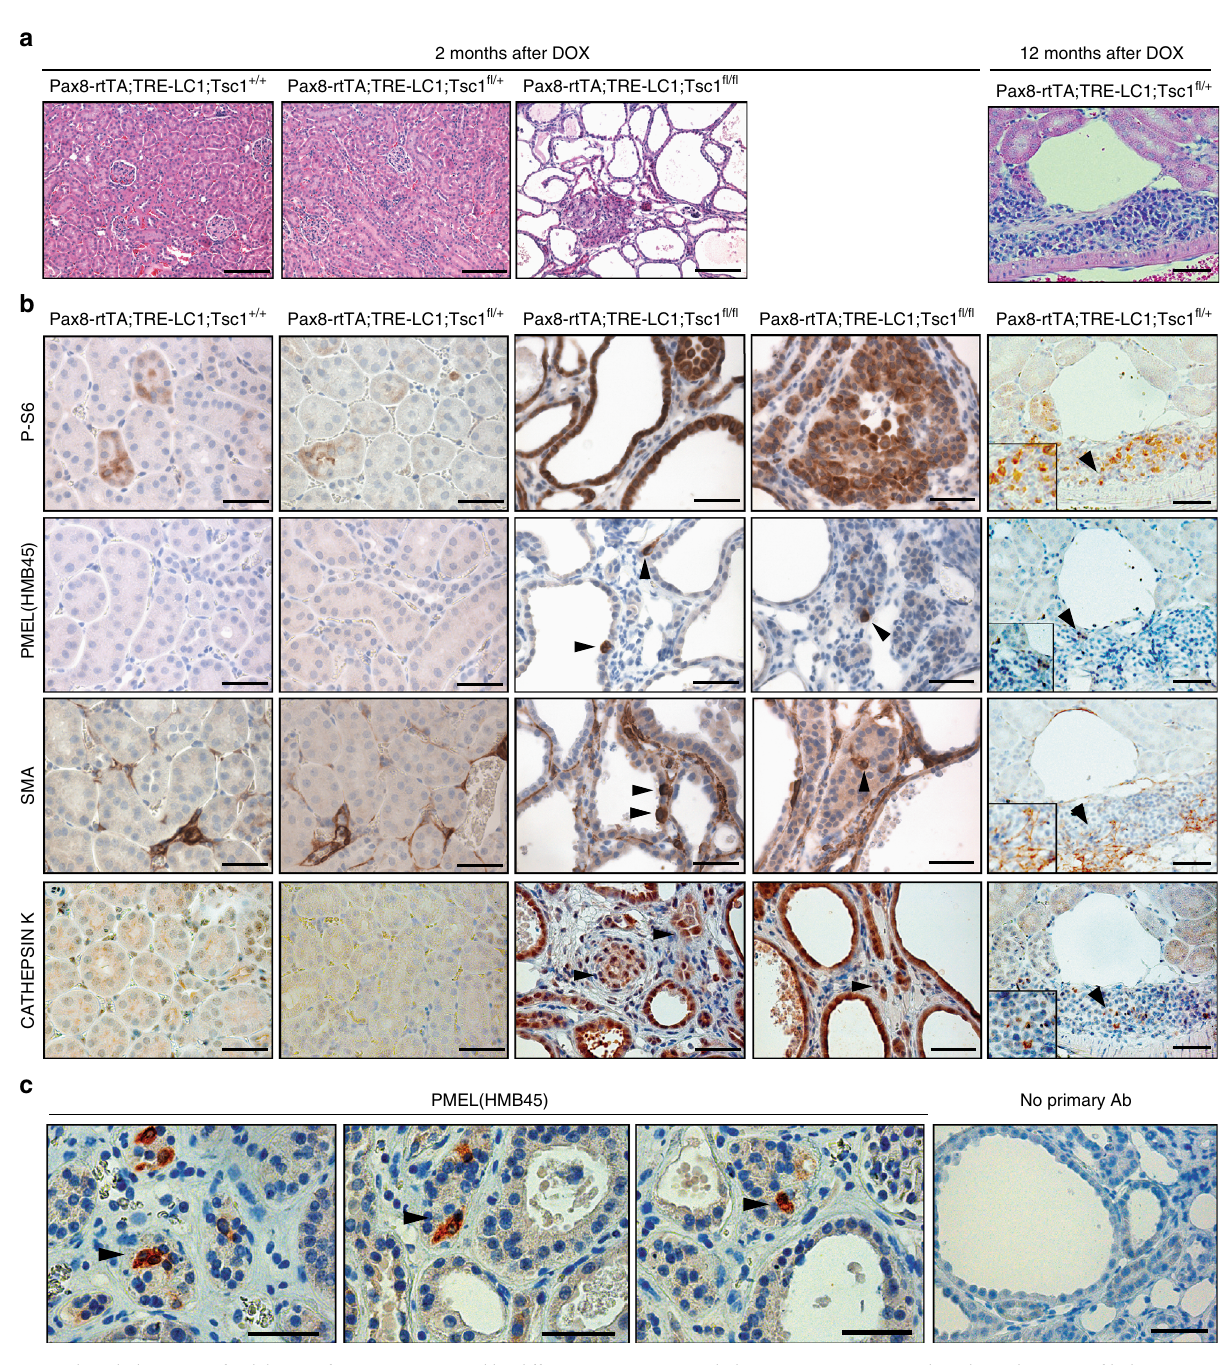
Fig. 5 Renal epithelium-speci fi c deletion of Tsc1 causes AML-like differentiation in mouse kidneys. a Representative histological images of kidneys 2 months after doxycycline treatment of Pax8-rtTA;TRE-LC1;Tsc1 + / + (wild type), Pax8-rtTA;TRE-LC1;Tsc1 fl / + (heterozygous Tsc1 mutant), Pax8-rtTA;TRE-LC1;Tsc1 fl / fl (homozygous Tsc1 mutant) mice and in the fi fth panel, images of kidneys 12 months after doxycycline treatment of Pax8-rtTA;TRE-LC1;Tsc1 fl / + . Scale bars: 150 μ m. b Representative immunohistochemical stainings of kidney sections from mice of the indicated genotypes using antibodies against phosphorylated Ser240/244 ribosomal protein S6 (P-S6), PMEL (HMB45), SMA and CATHEPSIN K. Arrowheads in the third, fourth and fi fth columns highlight positive cells lining cysts or in regions of adenoma-like proliferation. Scale bars: 50 μ m. c High magni fi cation pictures of positive cytoplasmic immunohistochemical staining of PMEL (HMB45) in Pax8-rtTA;TRE-LC1;Tsc1 fl / fl kidneys 2 months after doxycycline treatment. Scale bars: 50 μ factor binding sites (Supplementary Data 2) as being signi fi cantly is necessary for development of renal proximal tubules, is highly enriched in the sphere gene set. Genes encoding 14 different expressed in proximal tubule epithelial cells and regulates the transcription factors that have been implicated in the develop- expression of numerous proximal tubule speci fi c genes 31,32 . GSEA analyses also identi fi ed experimentally established HNF4A ment of many different cellular lineages were also upregulated > 8-fold in spheres (Supplementary Data 1) and 3 of these ( Hnf4a , and HNF1A target genes (Supplementary Data 2) and genes with bioinformatically predicted HNF4A and HNF1A transcription Tal1 , Tfec ) were con fi rmed by real time PCR analyses (Fig. 3c).